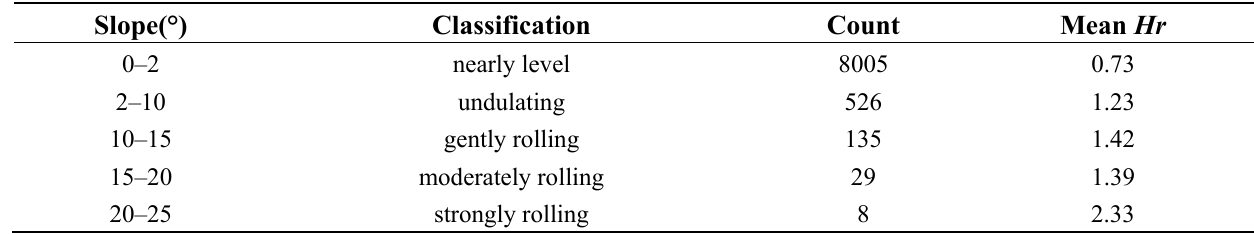
Table 4. (cid:1834)(cid:1870) values for the different slope ranges over the United States. Slope(°) Classification